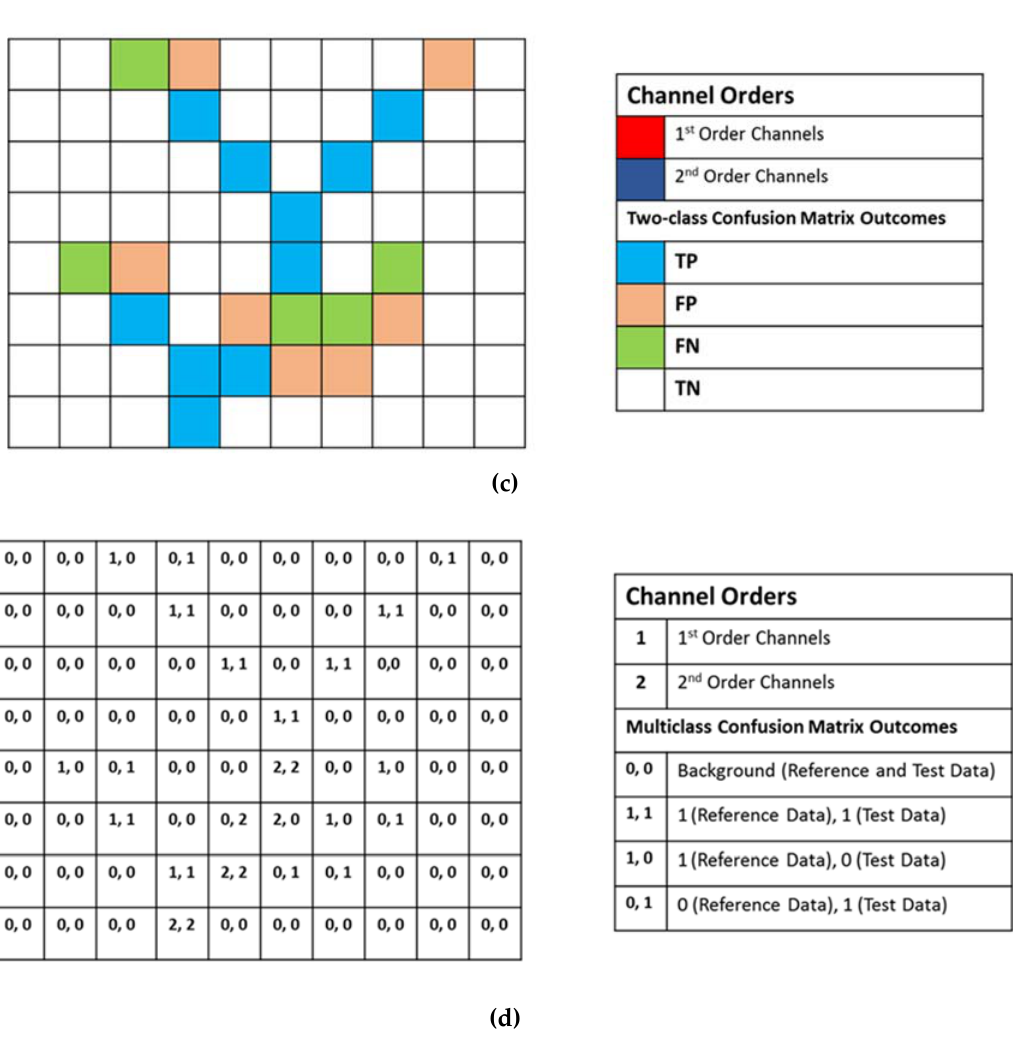
Figure 3. Sketch for comparing pixels of channel networks/orders using error matrices: (a) reference datasets, (b) test datasets, (c) two ‐ class confusion matrix outcomes resulting from matching between the whole networks in a and b (regardless of the channels’ orders), and (d) multiclass error matrix outcomes resulting from matching between channels that have the same order in a and b.TP, true positive; FP, false positive; FN, false negative; and TN, true negative.